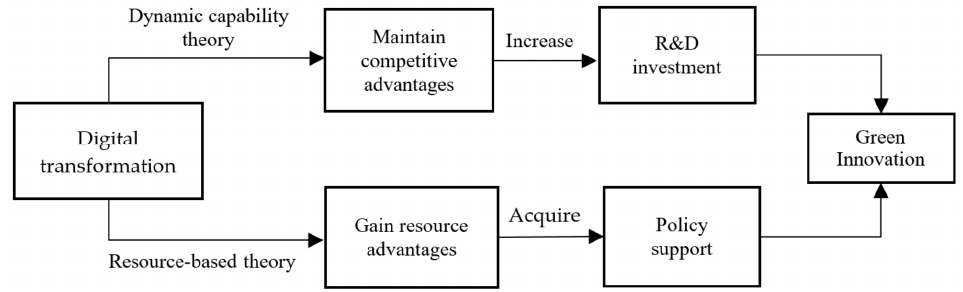
Figure 2. Transmission mechanism of the impact of digital transformation on green innovation.